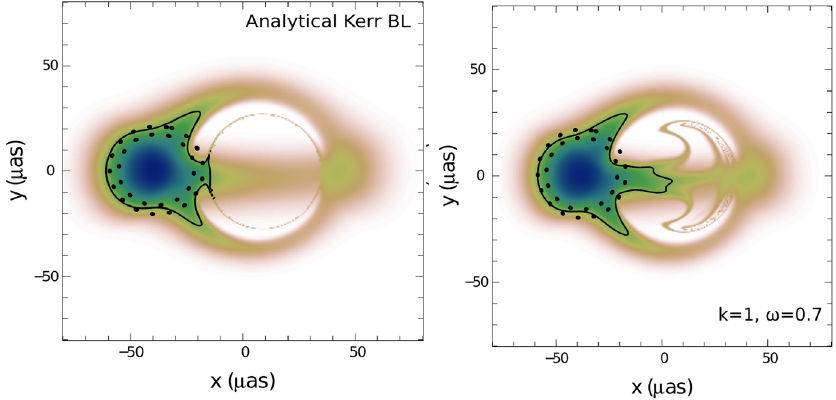
Fig. 22 Computed images as might be expected from the EHT for: (left) a Kerr black hole and (right) a fast spinning boson star with accretion according to certain assumptions. The similarity in images indicates that ruling out a BS candidate in images of Sgr A* may prove difficult. Reprinted with permission from Vincent et al. (2016); copyright by IOP